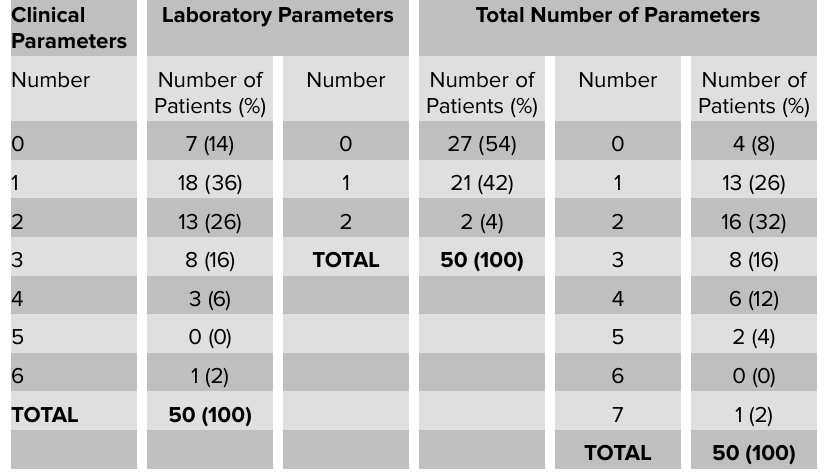
Table 5: Total number of the indices of disease severity identified in the sickle cell anemia patients. Clinical Laboratory Parameters Total Number of Parameters Parameters Number Number of Number Number of Number Number of Patients (%) Patients (%) Patients